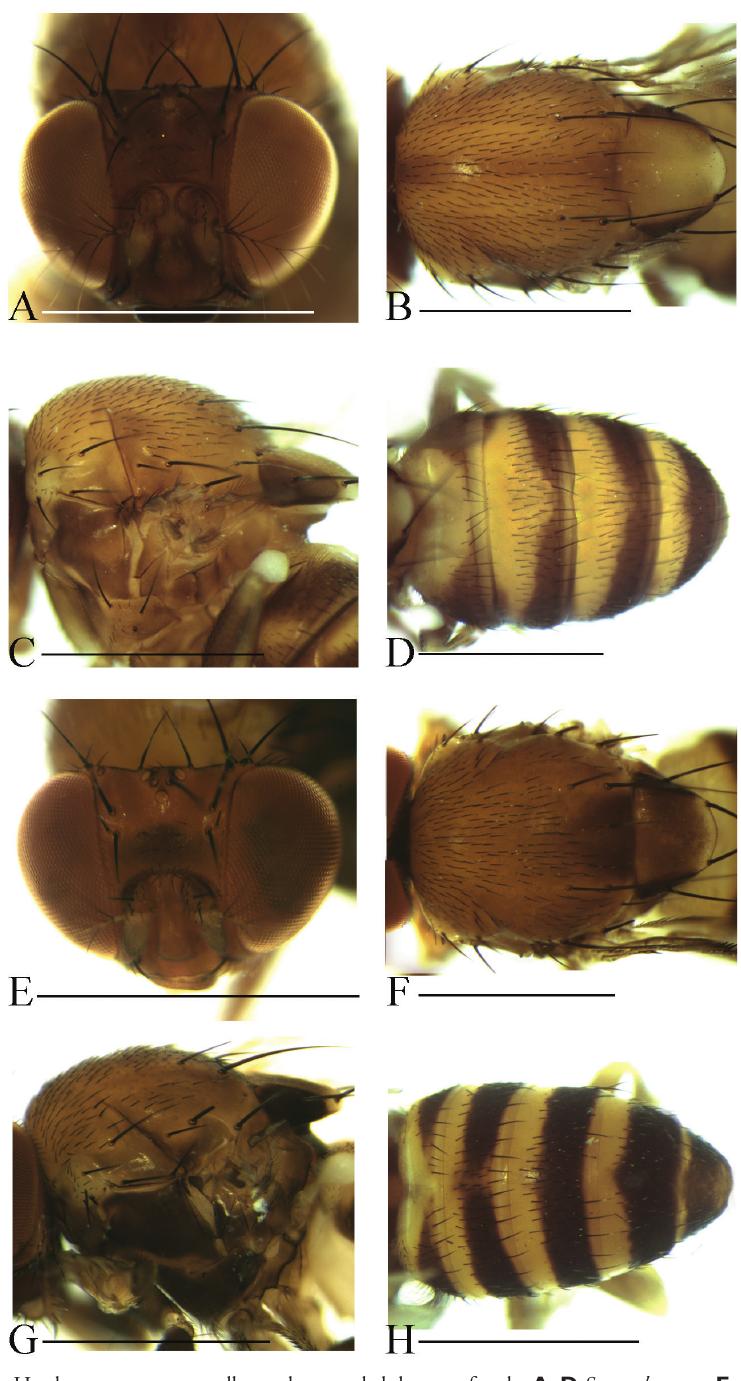
Figure 3. Head, mesonotum, scutellum, pleura and abdomen of male. A–D S. parabrunnea E–H S . pres- sobrunnea. Scale bars 1